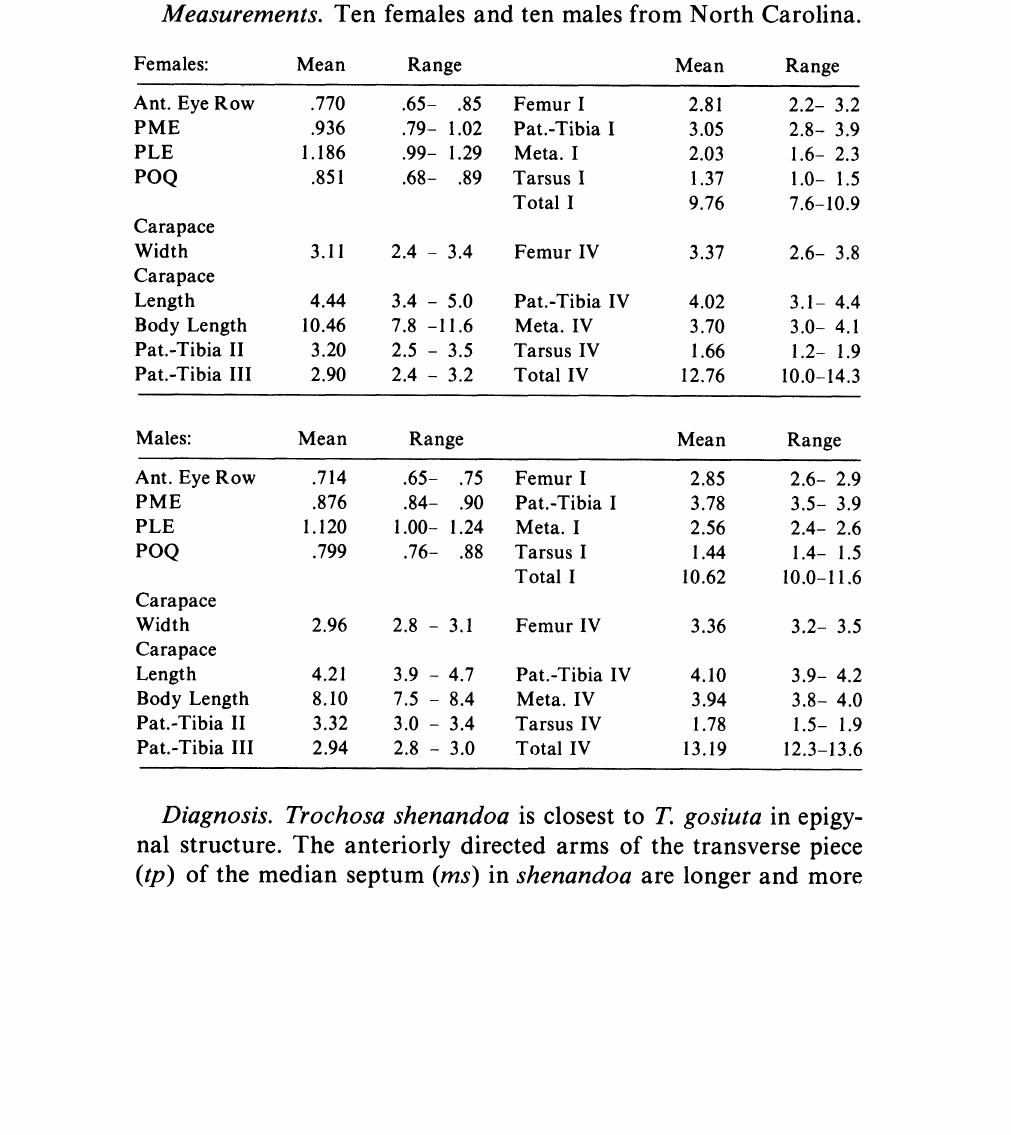
1979] Brady- Spider Genus Trochosa 201 Carapace light medium brown with broad median stripe of pale yellow-orange. Dashes within median stripe only faintly visible. Submarginal stripes paler. Dorsum of abdomen pale yellow to light orange in ground color, heavily mottled with gray-brown. Cardiac area solid brown outlined in gray. Venter cream colored with a few scattered spots. Legs pale yellow-orange to orange. Labium and endites yellow-orange with distal ends yellow to cream. Sternum yellow. Measurements. Ten females and ten males from North Carolina.